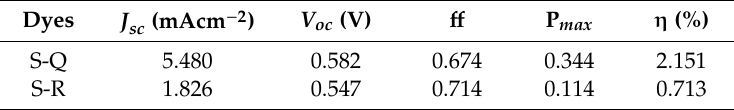
Figure 6. The photocurrent-potential (I-V) characteristics of the DSSCs with TiO2 film electrode sensitized by S-Q and S-R. Table 5. Q and R’s photoelectric parameters.